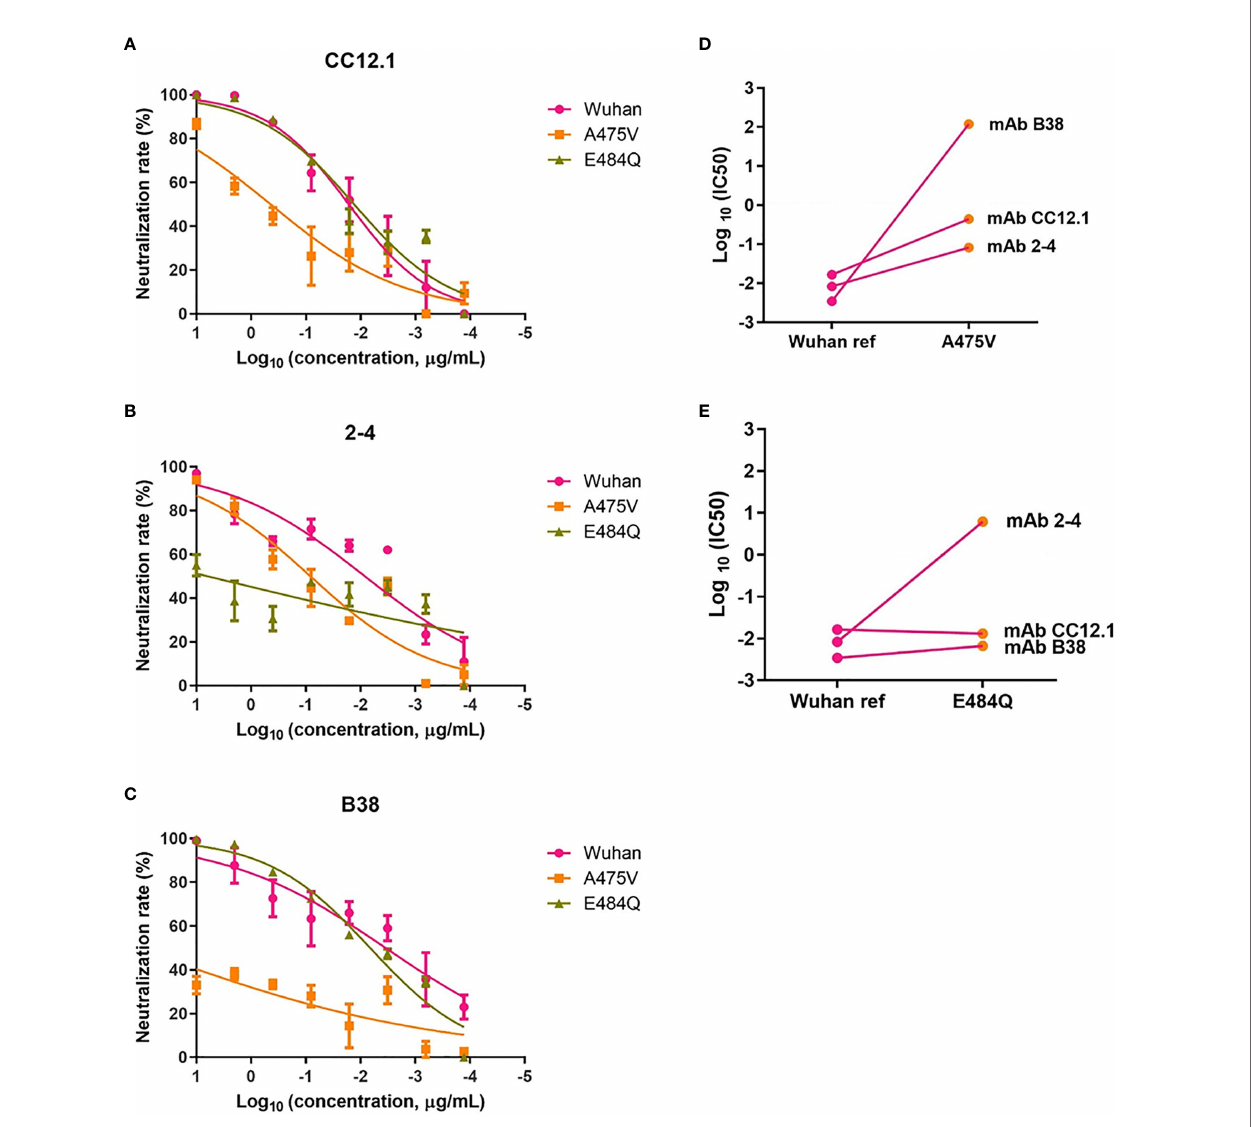
FIGURE 6 | Neutralization analysis of RBD-speci fi c mAbs (n = 3) against pseudoviruses with the Wuhan reference spike protein and variant spike protein A475V or E484Q. Neutralization curves of three mAbs (CC12.1, (A) ; 2-4, (B) ; B38, (C) against the Wuhan reference pseudovirus, A475V variant pseudovirus, and E484Q variant pseudovirus in the HEK293T/hACE2 cells. Paired neutralization analyses of three mAbs against the Wuhan reference and variant pseudoviruses of A475V and E484Q are shown in (D, E) . The 50% pseudovirus inhibition concentration (IC50) of mAb was de fi ned as the concentration at which the RLU values were reduced by 50% compared with the pseudovirus control wells, which was calculated in the GraphPad Prism 8 (GraphPad